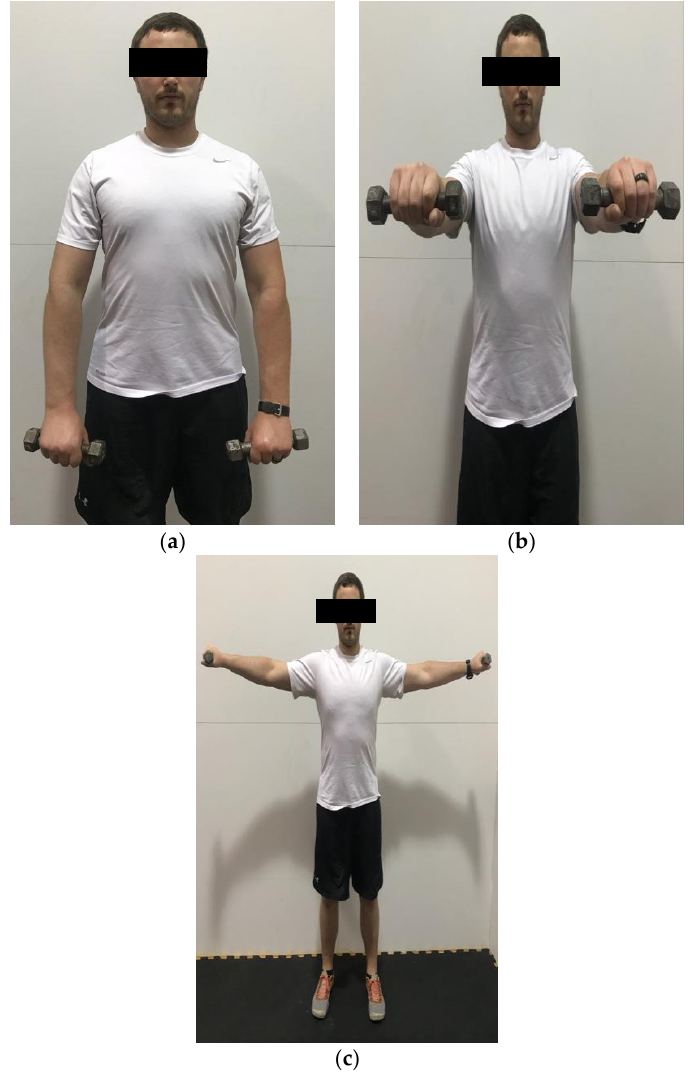
Figure 7. Demonstration of frontal raise and lateral raise in the ( a ) start position; ( b ) end position for frontal raise; ( c ) end position for lateral raise. Brace the abdominal muscles and slowly raise and lower the weight.